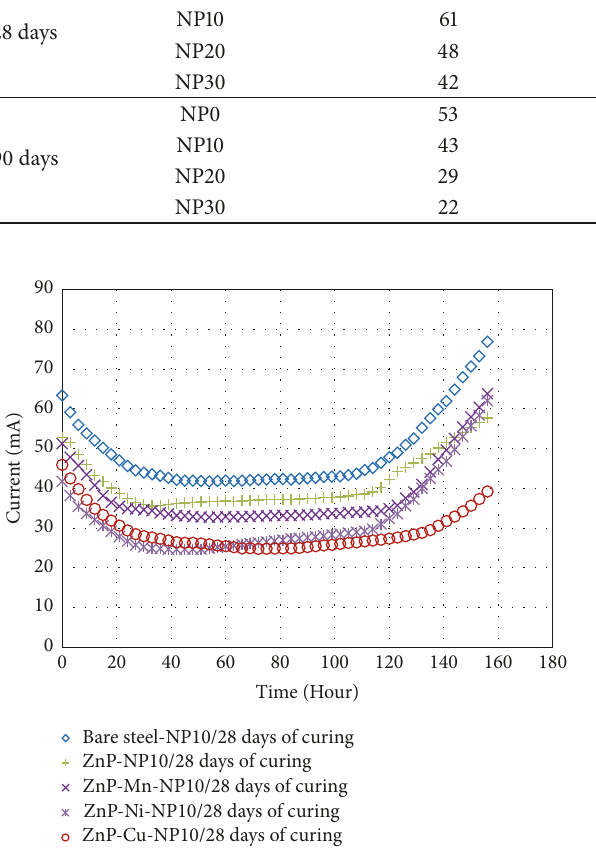
Figure 10: Time to cracking of RC specimens made with NP10- based cement and phosphated steel rebars after 28 days of curing.